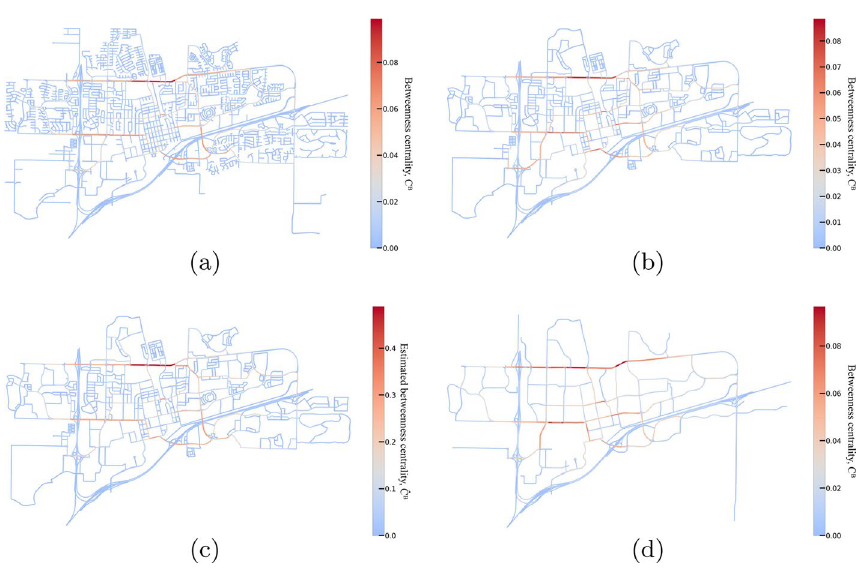
Fig. 4 C B distribution in Davis road network: a original, b proposed method, c proposed method with centrality estimation, and d simplified by omitting all residential